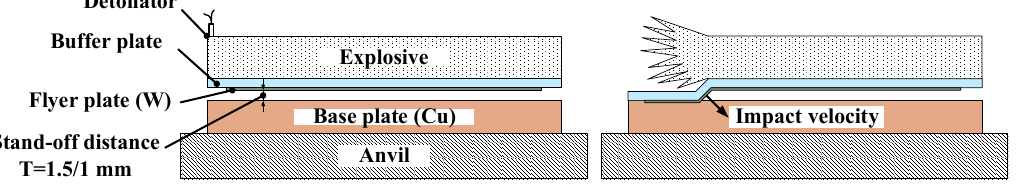
Figure 1. Schematic illustration of explosive welding of thin W and Cu plates.